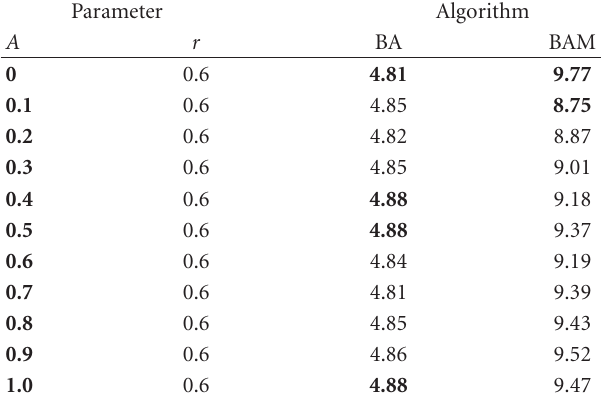
Table 11: Worst normalized optimization results on UCAV path planning problem on di ff erent A . The numbers shown are the worst results found after 100 Monte Carlo simulations of BA and BAM algorithms.